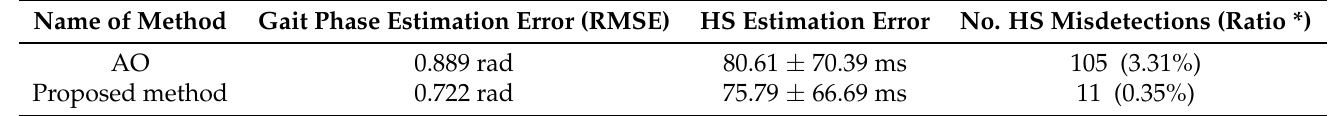
Table 2. Estimation performance when participants walked with knee